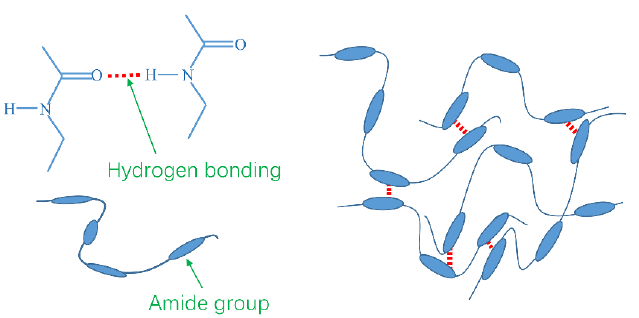
Figure 10. The schematic diagram of TQ-1 on improving the weak gel structure of oil-based drilling fluids.